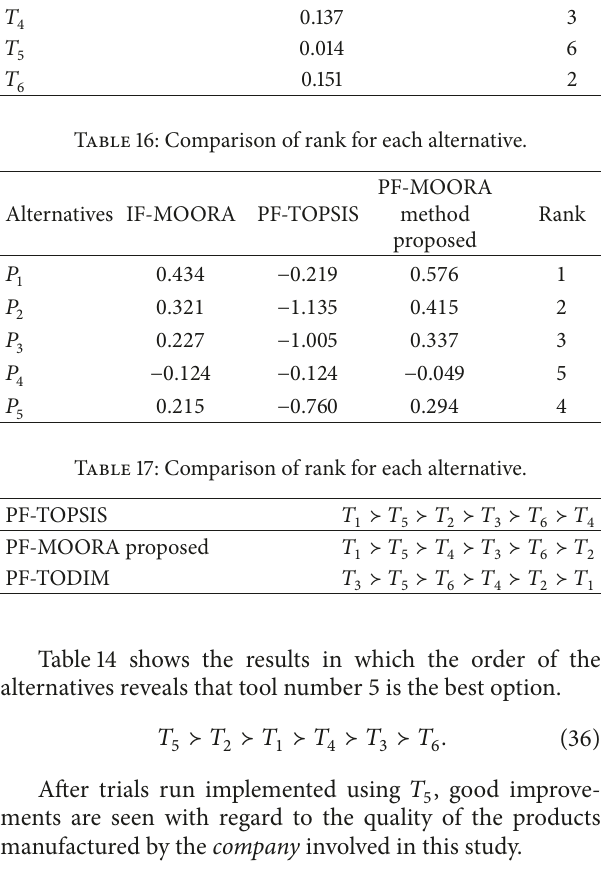
PF-MOORA method proposed